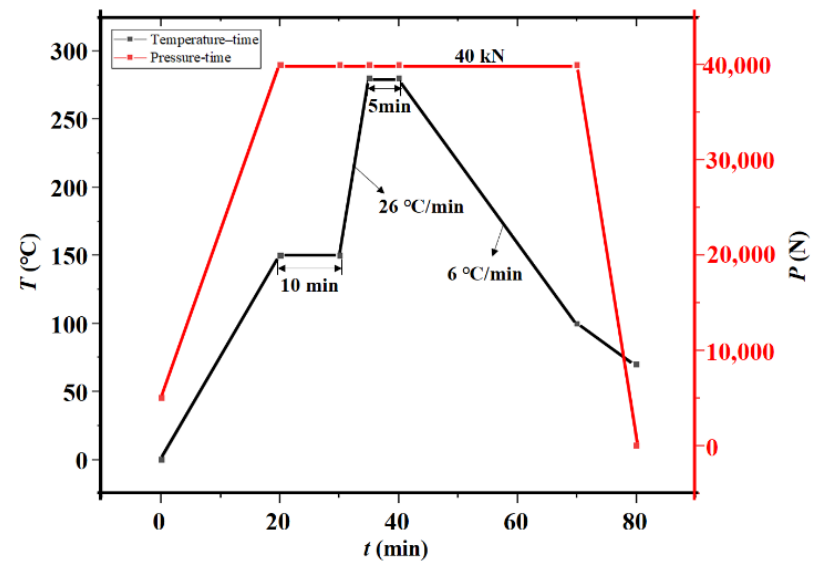
Figure 11. Temperature, pressure-time profile for Au-Sn bonding in the experiment.